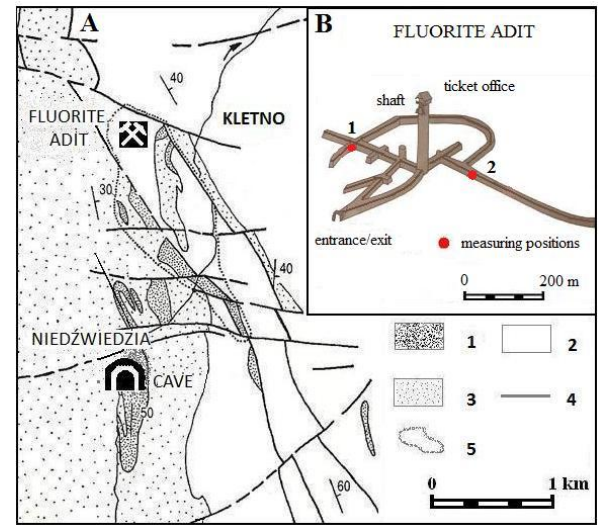
Fig. 2. Geological sketch of Kletno area with plotted sites of Bear Cave and Fluorite Adit (A) and a plan of Fluorite Adit with plotted sites of 222 Rn activity concentration measurements (B). 1: lenses of marbles and erlans, 2: gneisses, 3: metamorphic schists, 4: faults, 5: area of disused uranium mine in